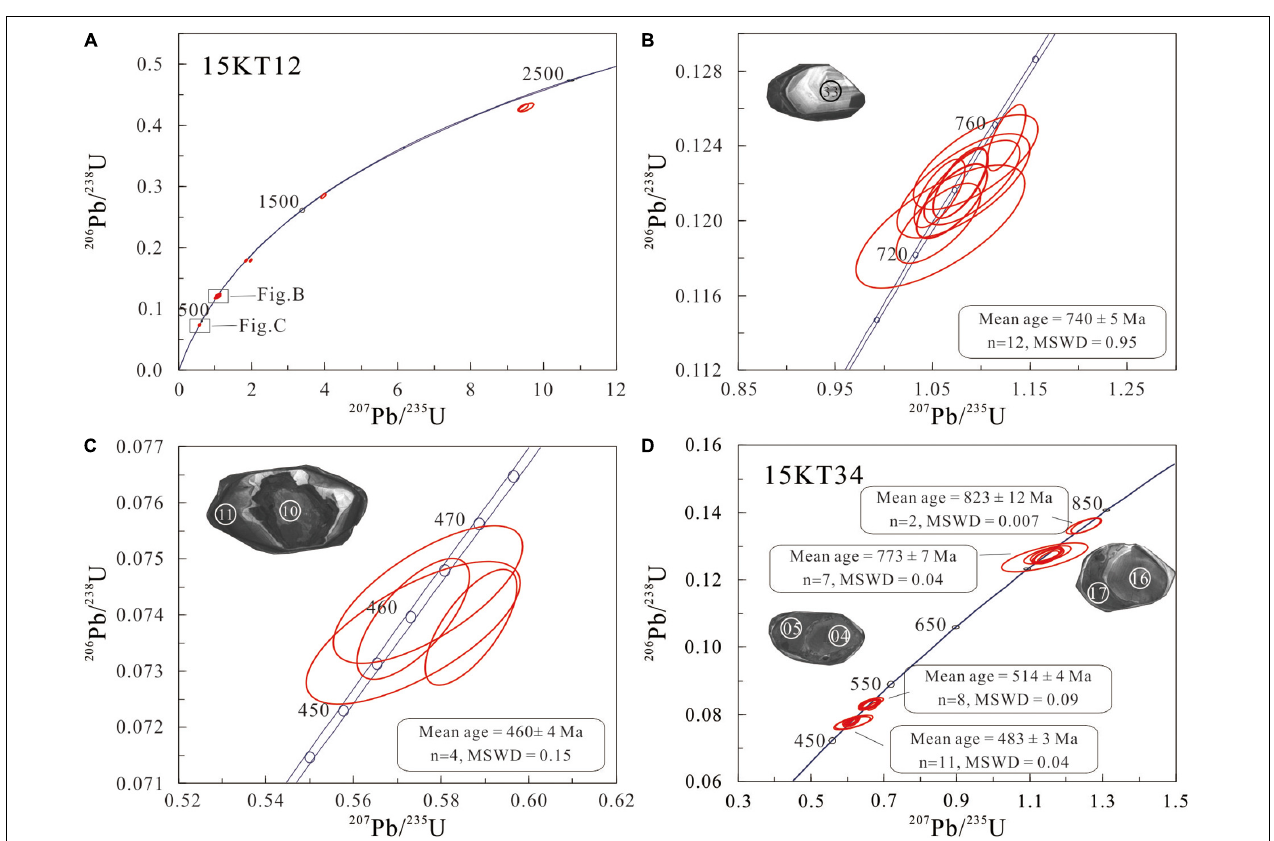
FIGURE 4 | U–Pb age Concordia plots for samples 15KT12 (A–C) and 15KT34 (D) . (B,C) are enlargements of (A) . Typical zircon cathodoluminescence (CL) images are also shown (the circle for LA-ICPMS dating is 30 µ m).